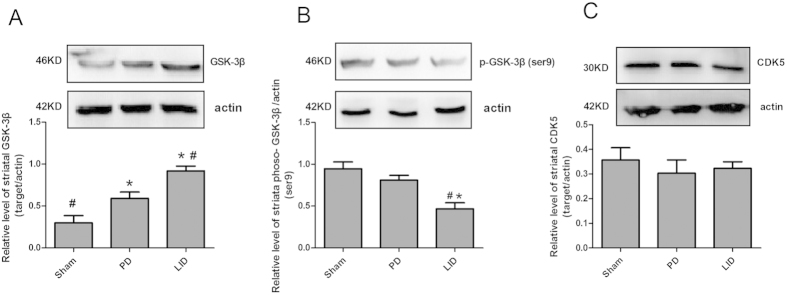
Protein levels were evaluated by Western blotting of proteins extracted from the striatum ipsilateral to the 6-OHDA lesion.They were assessed in extracts from sham (n = 4) or 6-OHDA-lesioned rats treated with vehicle (n = 4), pulsatile L-dopa (25 mg/kg) plus benserazide (6.25 mg/kg, n = 4) on day 23. (A) GSK-3β levels expressed relative to actin levels; (B) Phosphorylated GSK-3β (ser9) levels expressed relative to actin levels; (C) CDK5 levels expressed relative to actin levels. The data represent the mean of relative optical density ± SD; *p < 0.05 vs sham group; #p < 0.05 vs PD group (one-way ANOVA followed by LSD post-hoc analysis).